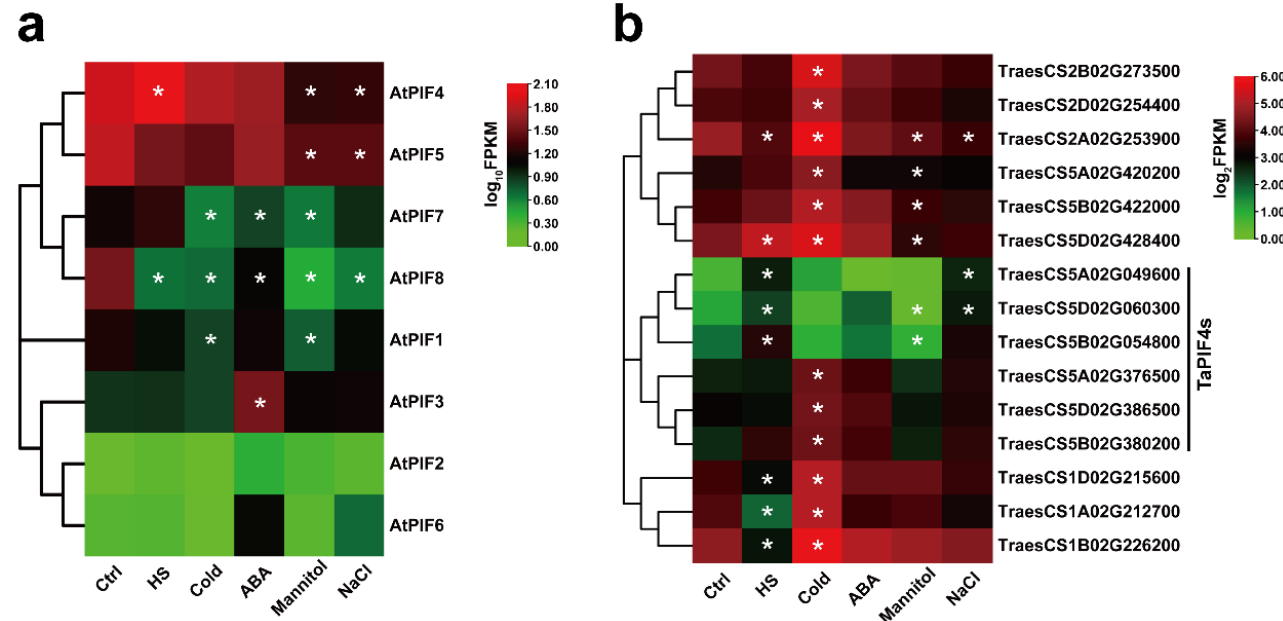
Figure 4. Expression analysis of the PIFs of Arabidopsis and Triticum under different abiotic stress treatments. ( a ) Hierarchical clustering of the expression profiles of AtPIF genes under different abiotic stress treatments. The FPKM values of each gene are normalized by log10. ( b ) Hierarchical clustering of the expression profiles of TaPIF genes under different abiotic stress treatments. The FPKM values of each gene are normalized by log2. Statistical differences calculated by DESeq2 are shown. Asterisks indicate the significant difference (* p < 0.05).